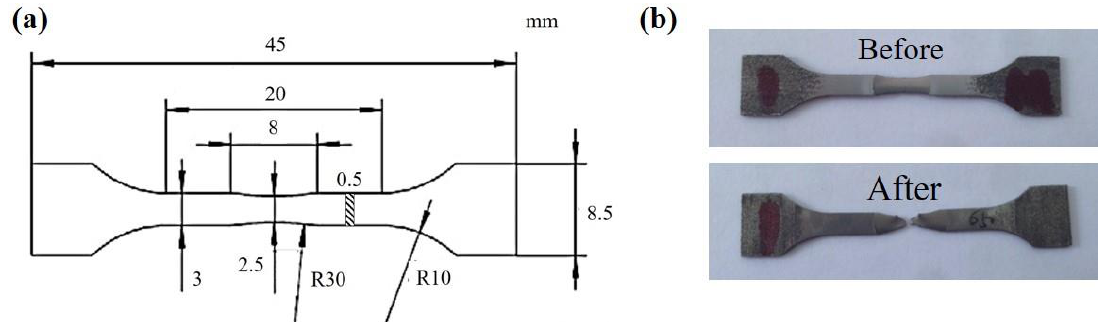
Figure 1. ( a ) Schematic image of in-situ tensile specimens; ( b ) Specimens before and after deformation.